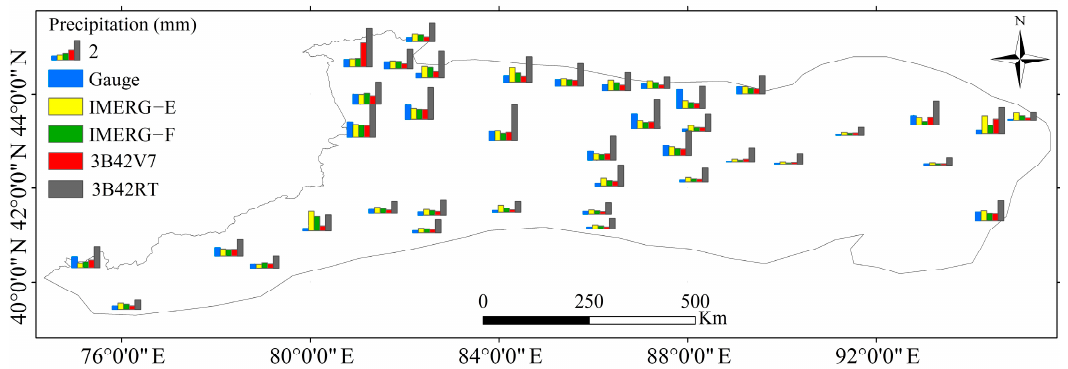
Figure 2. Spatial distribution of average daily precipitation (from rain gauges and four satellite products) over the Tianshan Mountains for the period of April 2014 to October 2017.